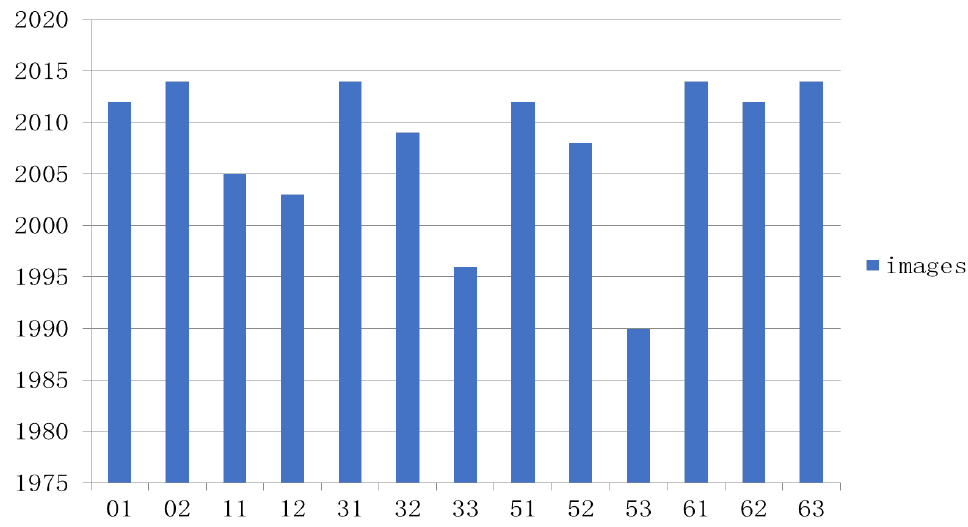
Figure 6. The number of images in the training set. The vertical axis is the number of images, and the horizontal axis is the category of different